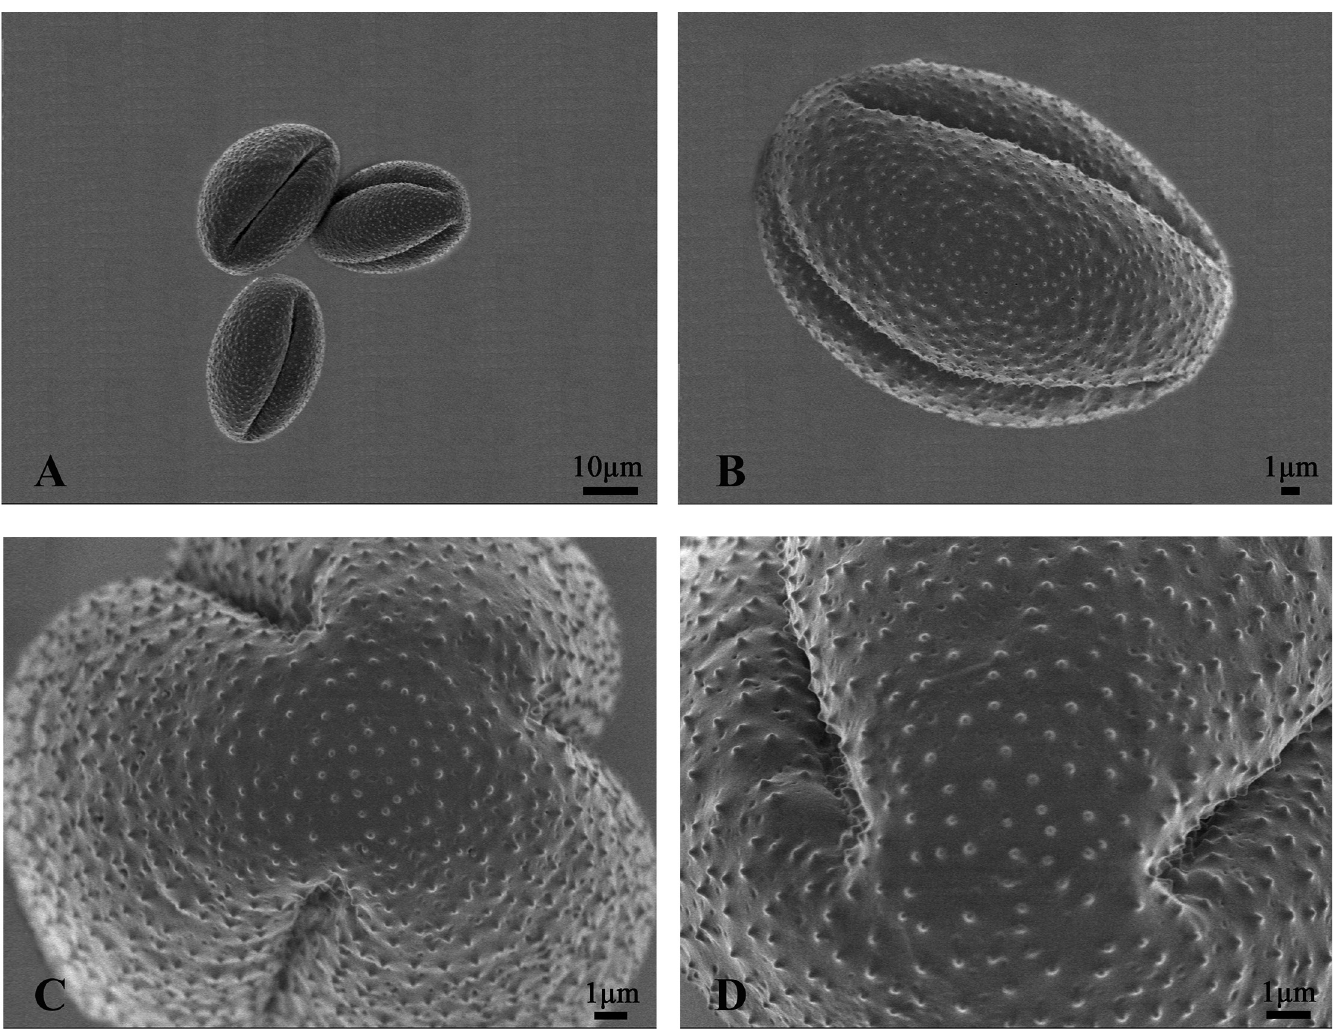
Fig 2. Scanning electron microscopy views of pollen grains of Clematis serratifolia . (A) The pollens of Clematis serratifolia ; (B-C) Pollen in the equatorial view and in the polar view; (D) The ornamentation in pollen‘s surface.